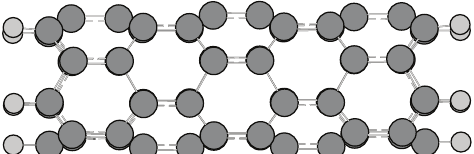
Figure 1: Optimized geometry of the finite (5, 0) zigzag SWCNT (C 60 H 20 ). Gray color depicts carbon atoms and light gray is hydrogen.